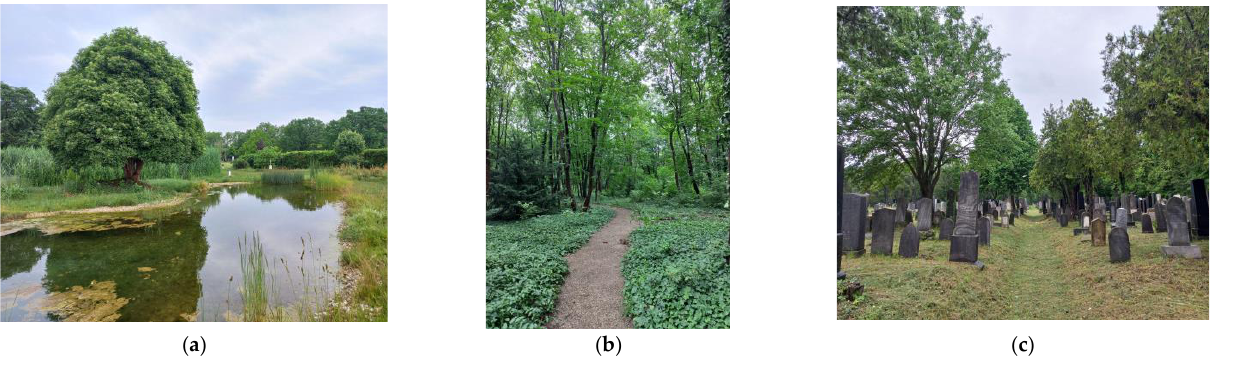
Figure 5. Zentralfriedhof Wien: ( a ) biotope in the Naturgarten, ( b ) path in the forest cemetery, ( c ) the old Jewish cemetery (authors ’ photos, 2022).